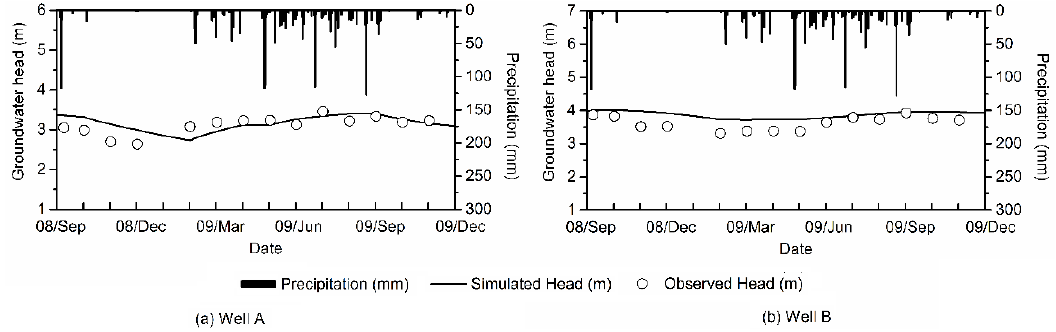
Figure 6. The monthly variation of observed and simulated groundwater head of ( a ) Well A and ( b ) Well B during the period from September 2008 to December 2009.